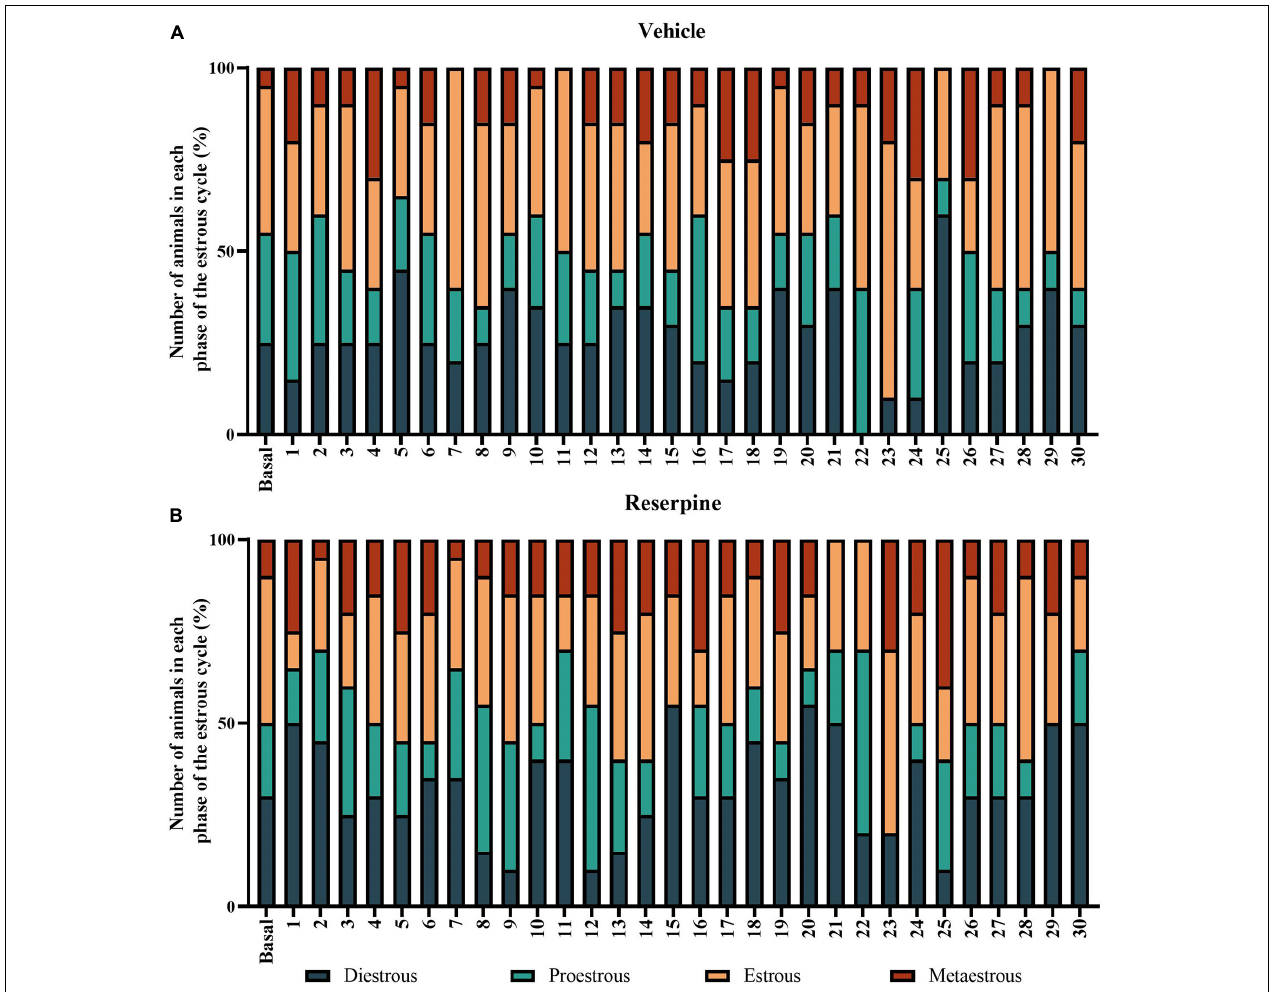
FIGURE 7 | Prevalence of the phases of estrous cycle throughout the 30-day repeated treatment with vehicle (A) or 0.1 mg/kg reserpine (B) in female rats. Values were expressed by percentage of animals in each phase in each day of the